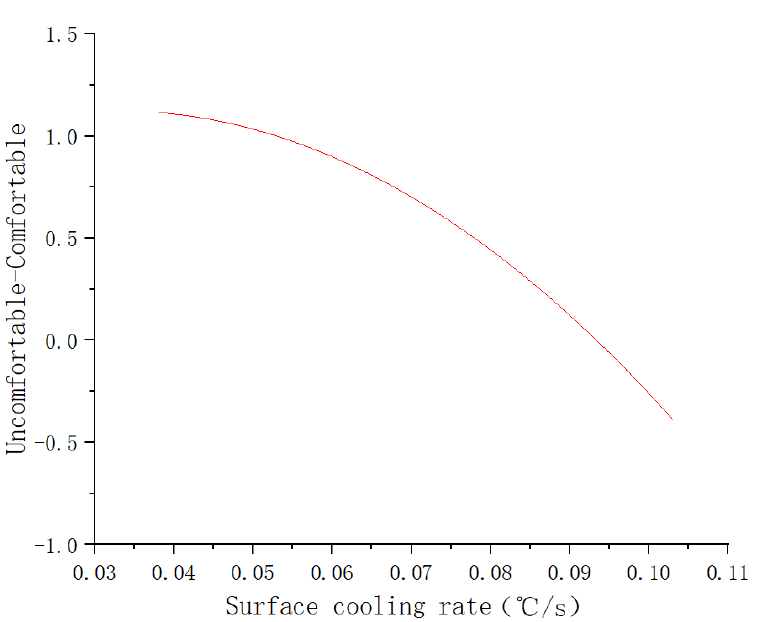
Figure 15. “Uncomfortable-Comfortable” and surface cooling rate polynomial fitting function.